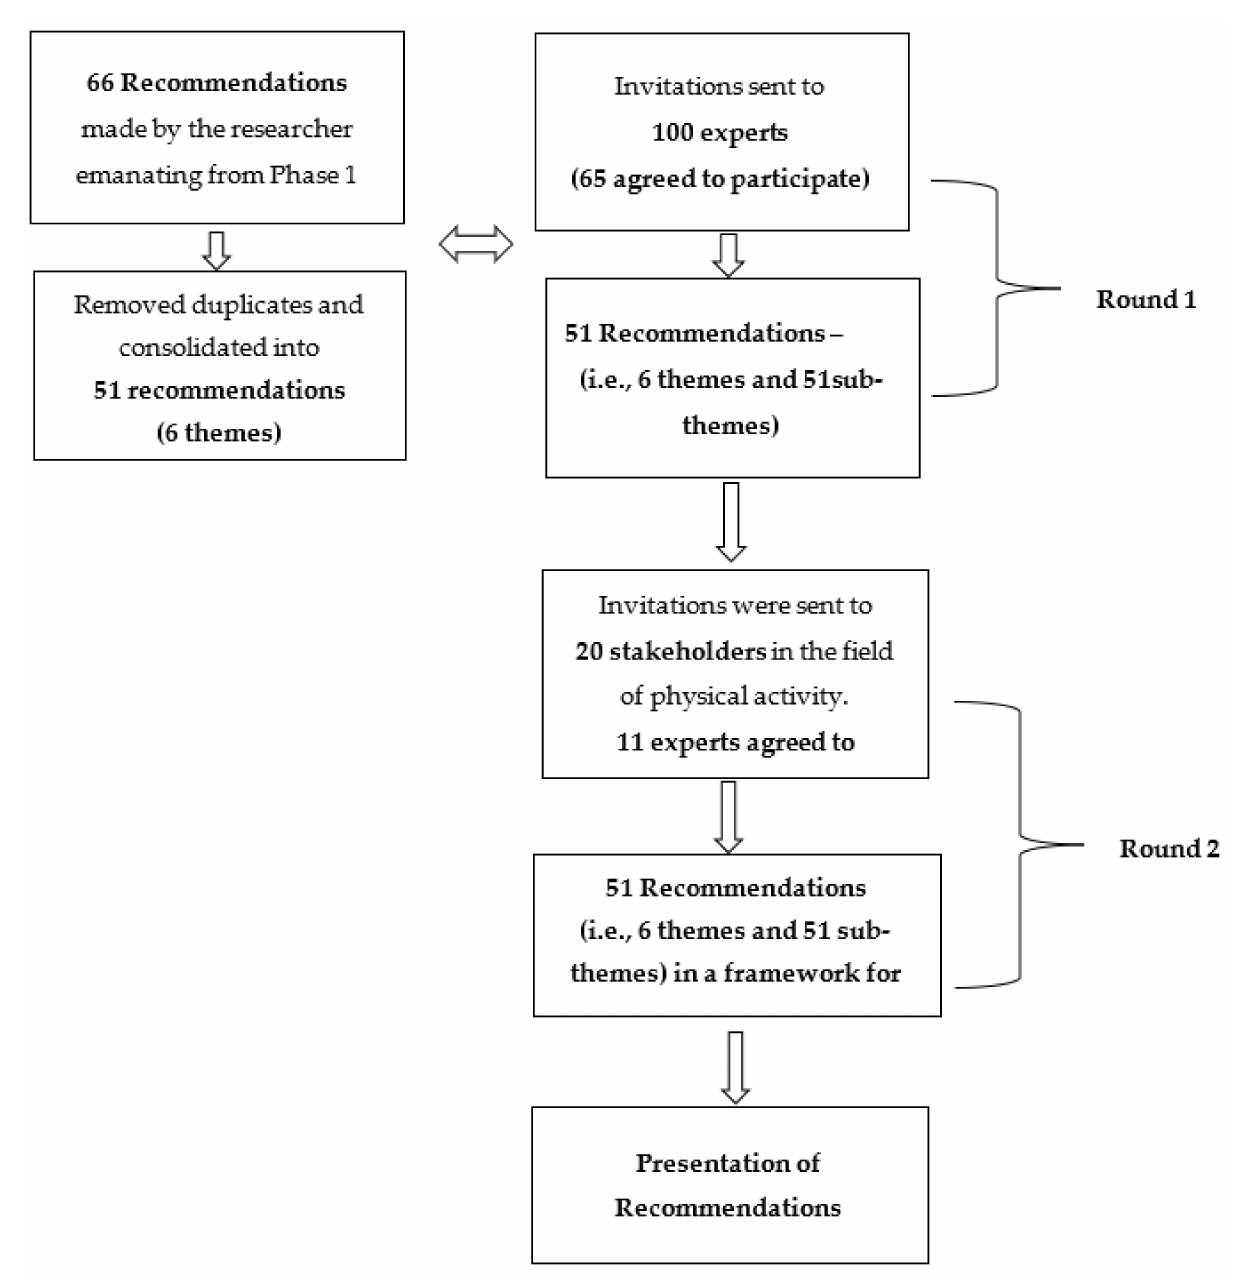
Figure 2. Agreement